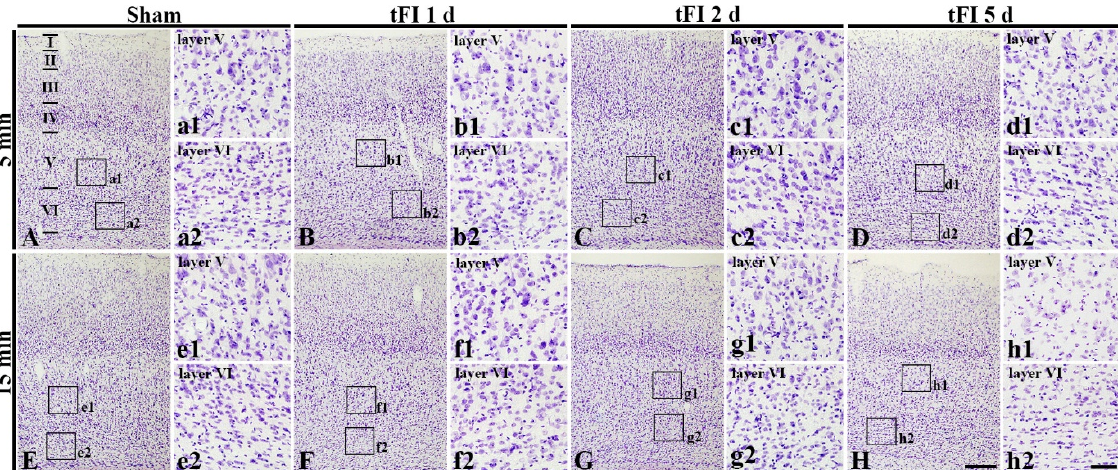
Figure 1. Change in spontaneous motor activity (SAM). SMA is evaluated in the traveled entire distance (meters) in 60 min at one day after tFI ( n = 5 or 7, respectively; * p < 0.05, significantly different from the mild and severe sham group, and † p < 0.05, significantly different from the mild tFI group at the corresponding time). The bars indicate the means ± SEM.